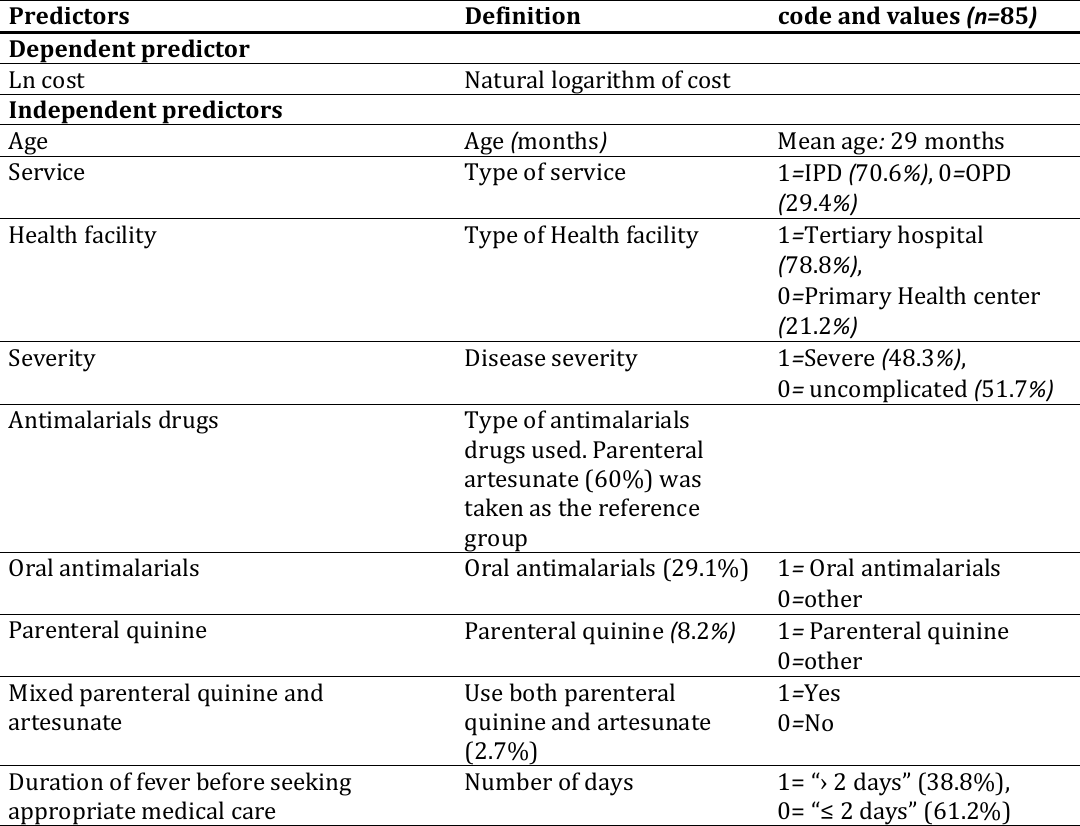
Table 4: Potential variables used in stepwise linear regression